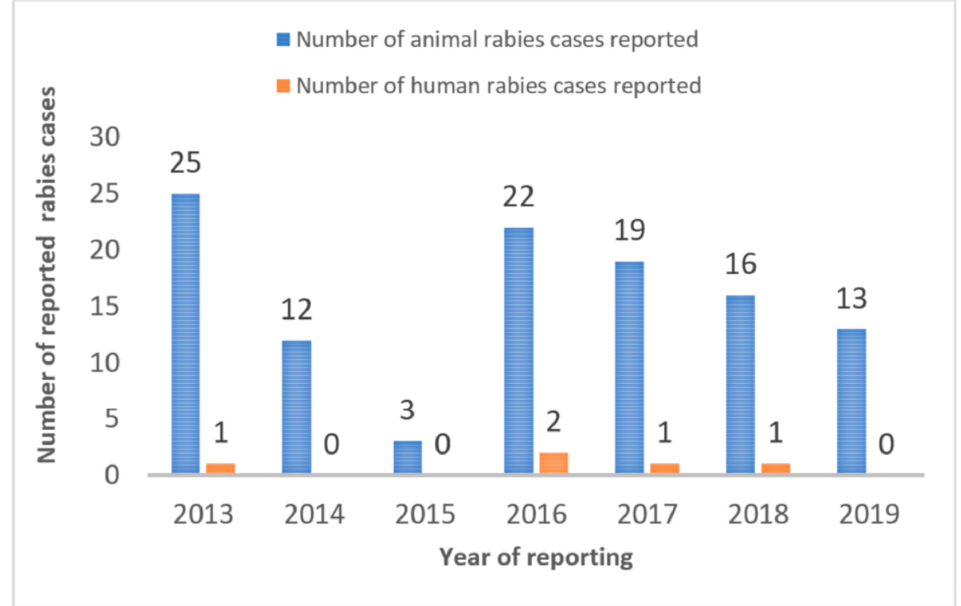
Figure 11. Reported rabies cases in animals and humans in Cebu City, pre- and post-2018 vaccina- tion